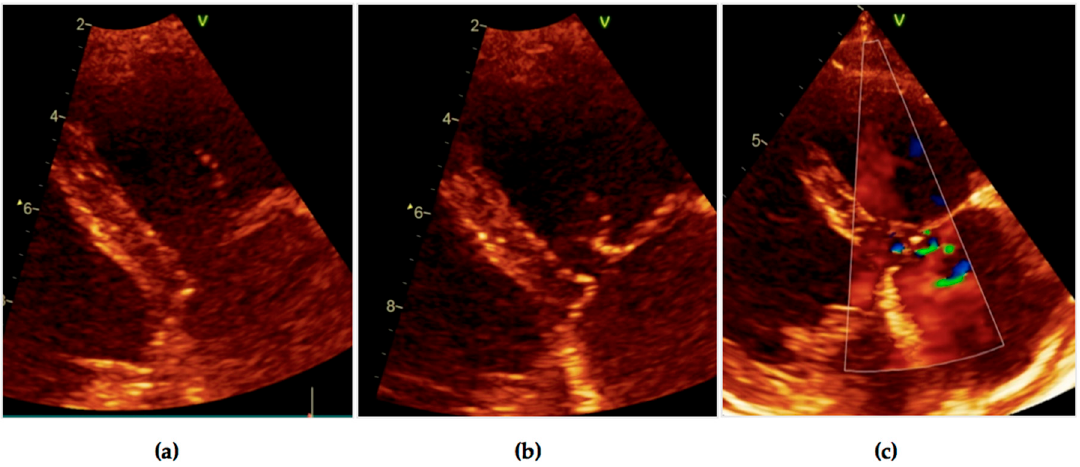
Figure 8. Transthoracic echocardiography, modified parasternal long axis–posterior leaflet of the tricuspid valve with chordal rupture ( a , b ), minor tricuspid regurgitation ( c